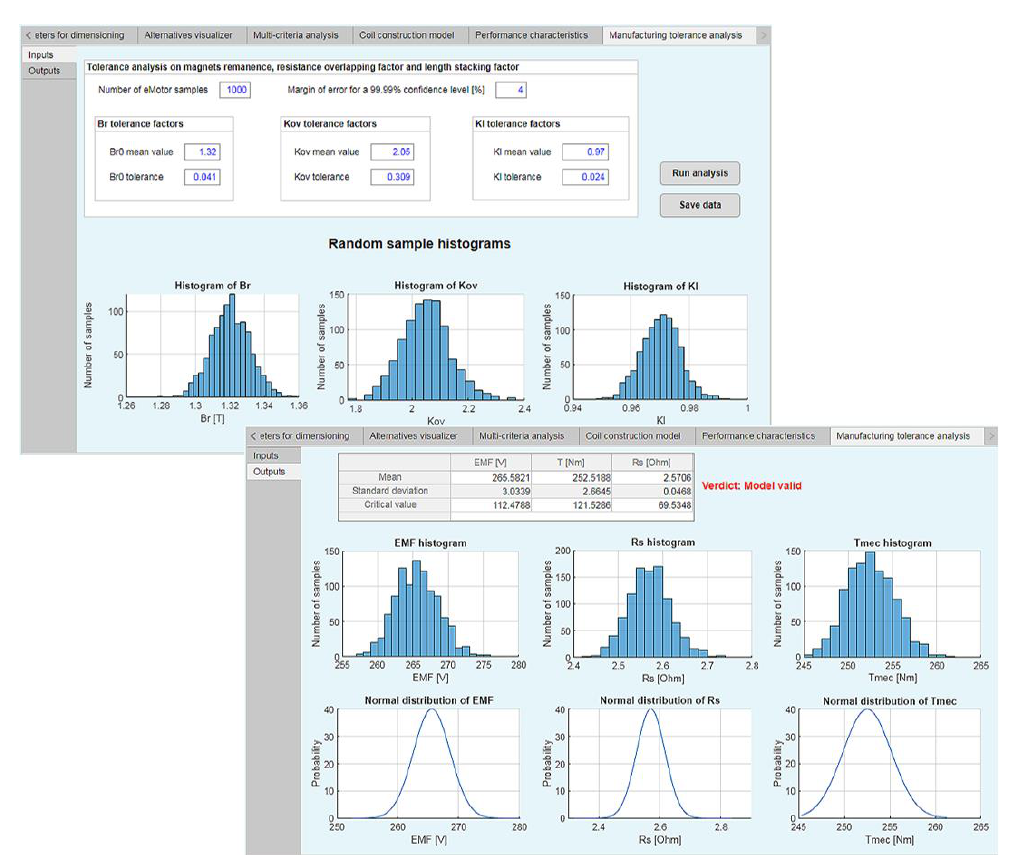
Figure 17. Manufacturing tolerance analysis based on fixed design parameters.